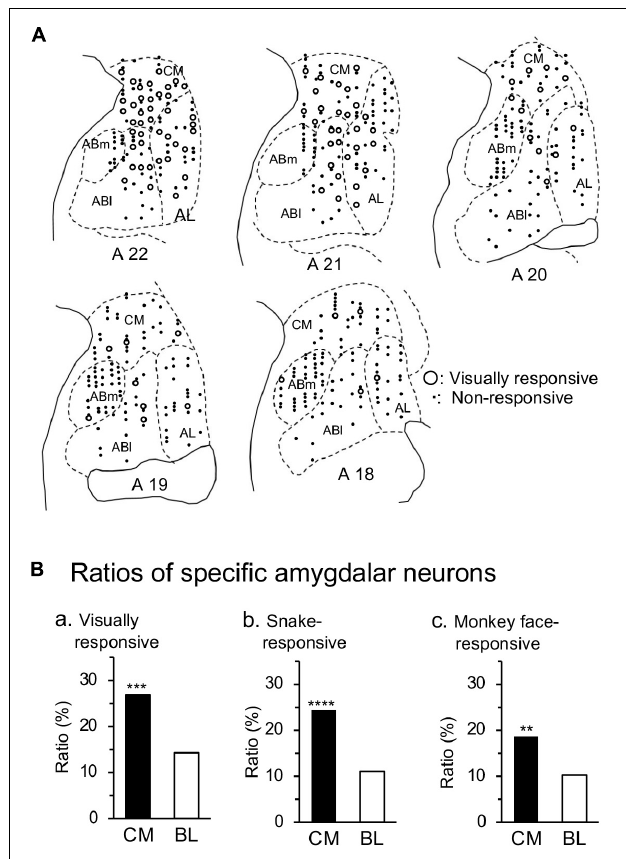
FIGURE 7 | Recording sites in the amygdala. (A) Recording sites are plotted on coronal sections at the different anteroposterior axis (A-P levels). Numbers below coronal sections, distance (mm) anteriorly from the interaural line; open circles, responsive neurons ( n = 95); dots, non-responsive neurons. The amygdala was divided into four areas: CM, corticomedial group; AL, lateral nucleus; Abl, basolateral nucleus; Abm, basomedial nucleus. (B) Ratios of responsive neurons from all the recorded neurons in the corticomedial and basolateral groups of the amygdala. The ratios of the visually responsive (a), snake-responsive (b), and monkey face-responsive (c) neurons were significantly greater in the corticomedial group of the amygdala than in the basolateral group of the amygdala. ****, ***, **, p < 0.0001, 0.001, 0.01 ( χ 2